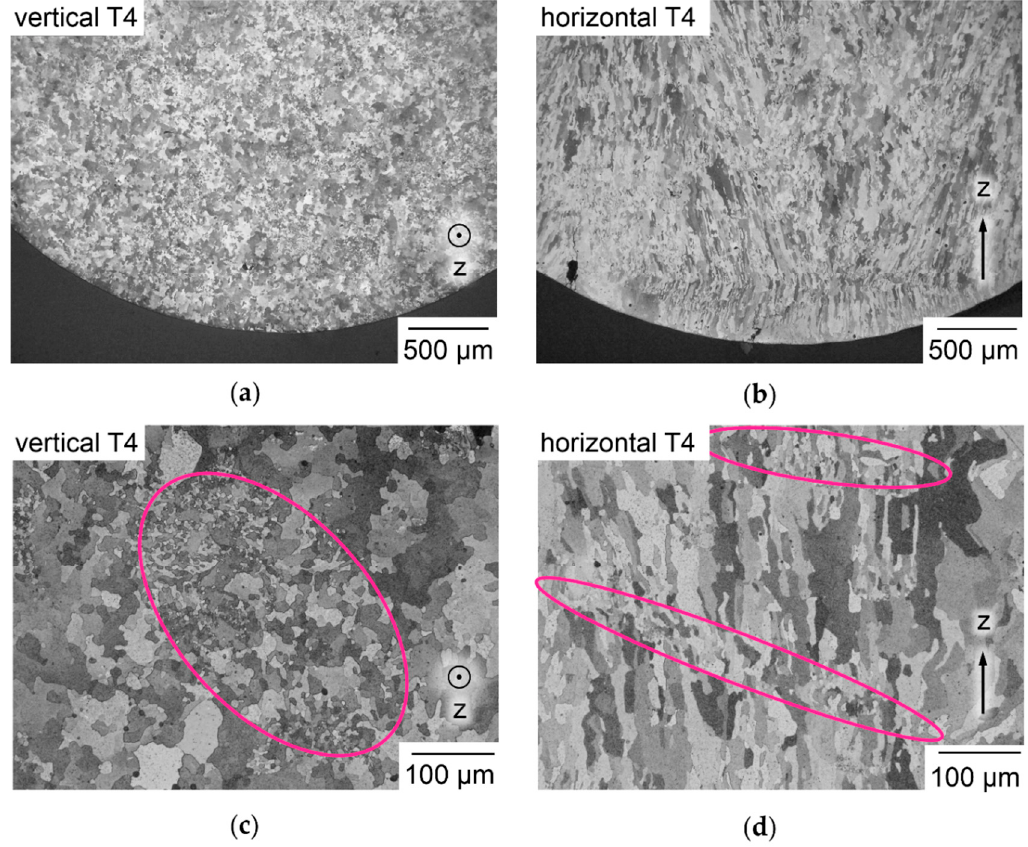
Figure 17. Etched micrographs of tensile specimen orthogonal to pulling direction; ( a ) vertically built specimen sectioned orthogonally to buildup direction Z with equiaxed structure; ( b ) horizontal specimen sectioned parallel to Z with elongated epitaxial grains oriented along heat flow during buildup; ( c ) larger magnification of a sample like (a); ( d ) larger magnification of a sample like (b).